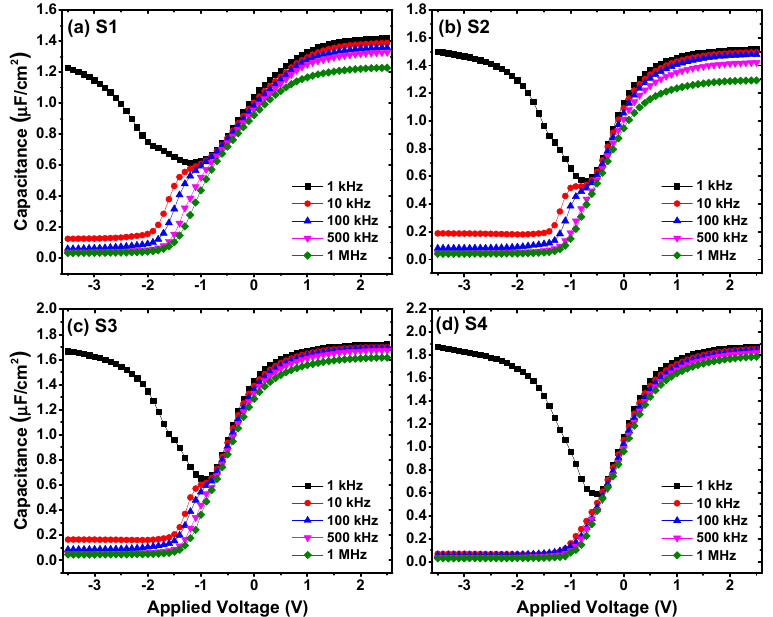
Figure 7. Multi-frequency C-V characteristics measured of the fabricated Al/HfO 2 /La 2 O 3 /Ge MIS capacitors with different ALD cycles of La 2 O 3 passivation layer. ( a ) The control sample; ( b ) 5 ALD cycles of La 2 O 3 passivation layer; ( c ) 10 ALD cycles of La 2 O 3 passivation layer; and ( d ) 15 ALD cycles of La 2 O 3 passivation layer.